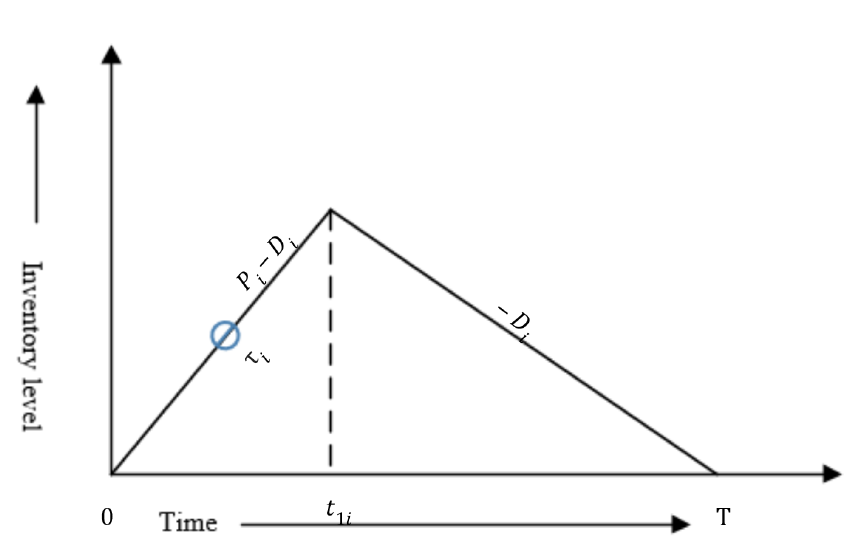
Figure 2. Economic production quantity model for multi-product